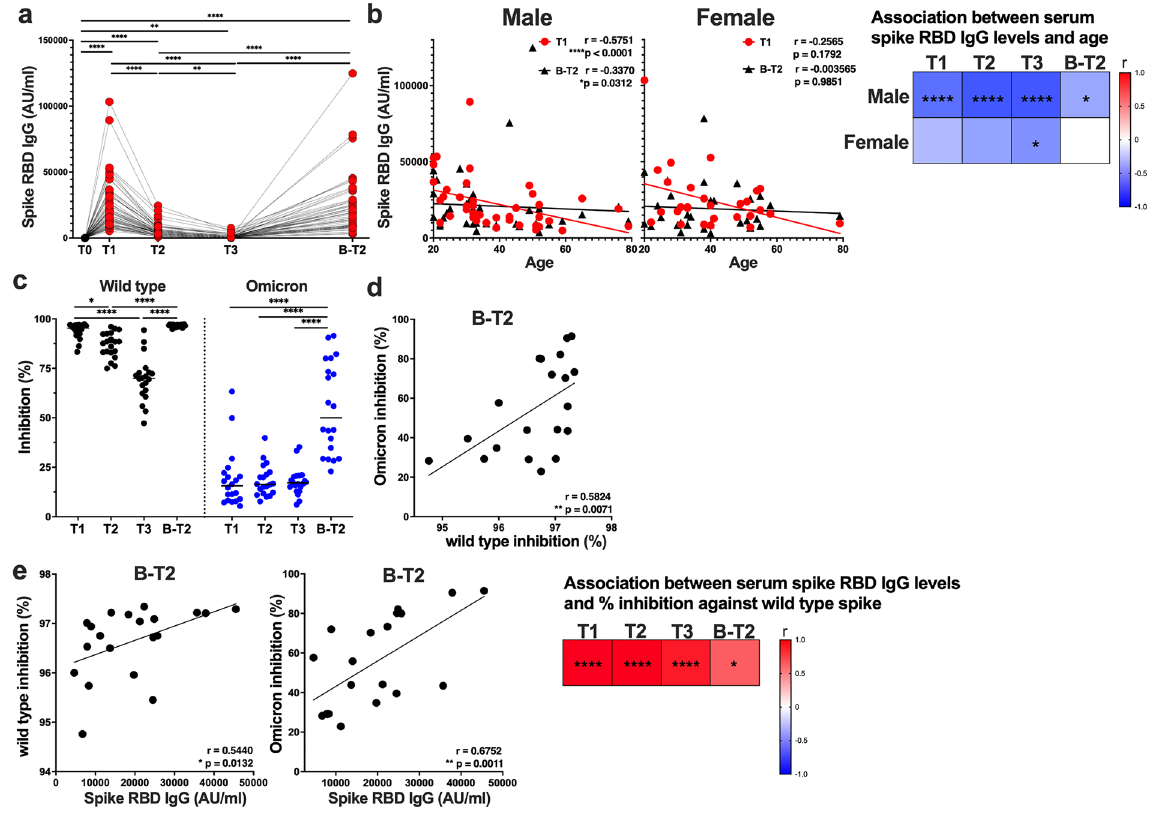
Figure 2. SARS-CoV-2 mRNA vaccine induced serum antibody titers and neutralizing activity. Serum samples were obtained before (T0) and 1 week (T1), 2 months (T2), and 6 months (T3) after the 2nd dose of the BNT162b2 mRNA vaccine and 2 months after the 3rd dose of the vaccine (B-T2). ( a ) Serum concentrations of the SARS-CoV-2 spike receptor binding domain (RBD) IgG at the indicated time points. ( b ) Graphs showing correlations between age and serum spike RBD IgG levels at T1 and B-T2 in males and females. Heatmap showing the associations of age with serum spike RBD levels at T1, T2, T3, and B-T2 in males and females. ( c ) Capacities of the sera to inhibit the interaction of angiotensin-converting enzyme 2 receptor and spike RBD proteins of wild-type (WT) SARS-CoV-2 and the Omicron variant. ( d ) Correlation between serum inhibiting capacities against the WT-RBD and Omicron-RBD at B-T2. ( e ) Graphs showing the correlation between serum spike RBD IgG levels and inhibition capacity against WT-RBD (left) and Omicron-RBD (right) at B-T2. Heatmap showing the correlations between serum spike RBD IgG levels and neutralizing capacities at T1, T2, T3, and B-T2. Each dot indicates the value for one individual. Significant differences between groups were analyzed by the Friedman test. Correlations were analyzed using Spearman’s correlation analysis. * P < 0.05, ** P < 0.01, *** P < 0.001, **** P <